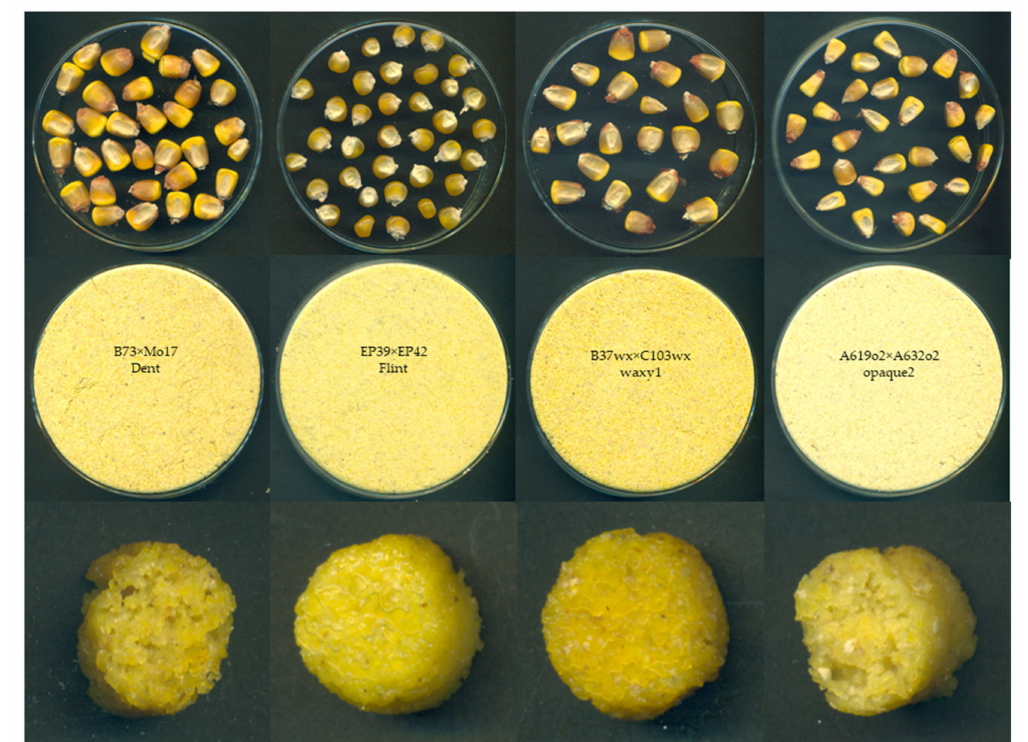
Figure 1. Grain, flour and bread from four maize hybrids representative of the dent, flint, waxy1 and opaque2 endosperm